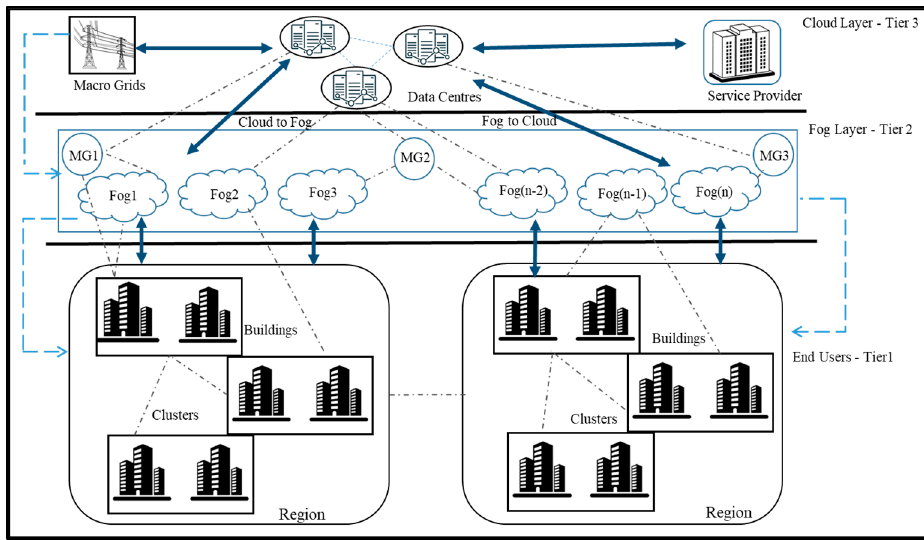
Figure 1. Proposed system model.